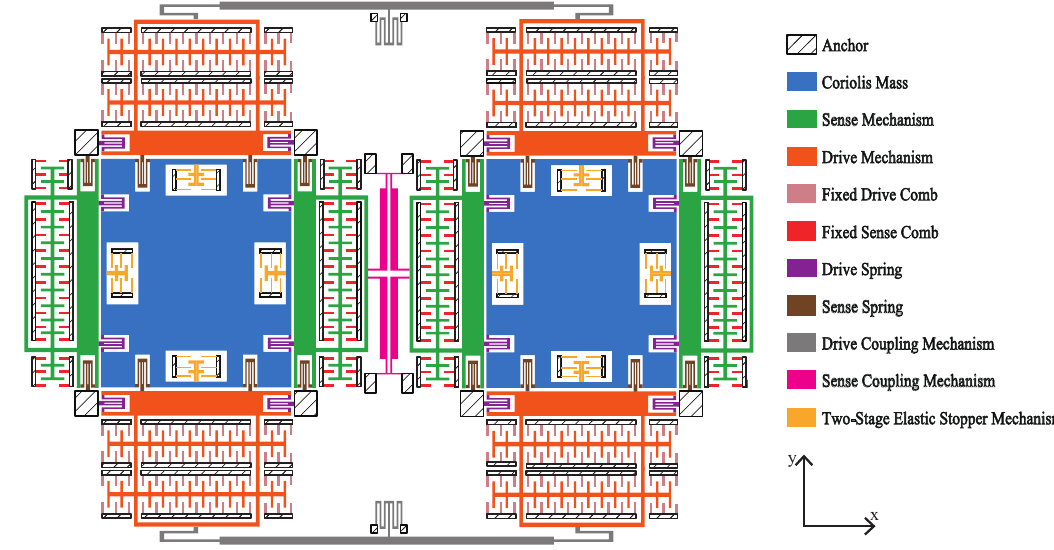
Figure 2. Structural schematic of the dual-mass MEMS